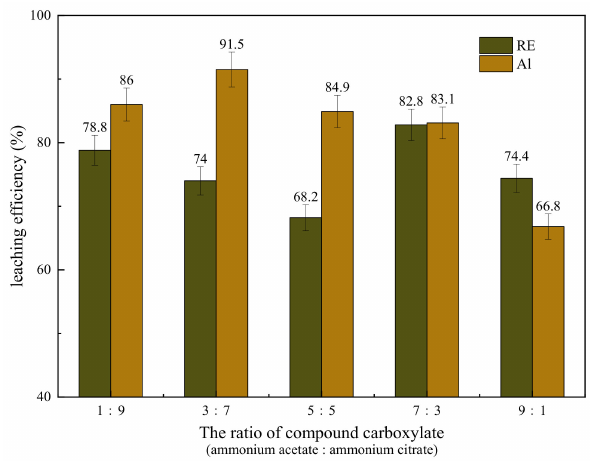
Figure 5. The leaching e ffi ciencies of RE and Al under di ff erent molar ratios of compound ammonium carboxylate.